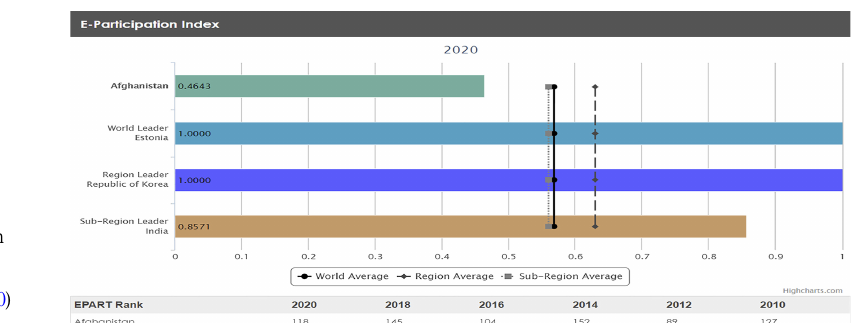
Figure 2. Afghanistan status in UN e-Government survey (2010, 2012,